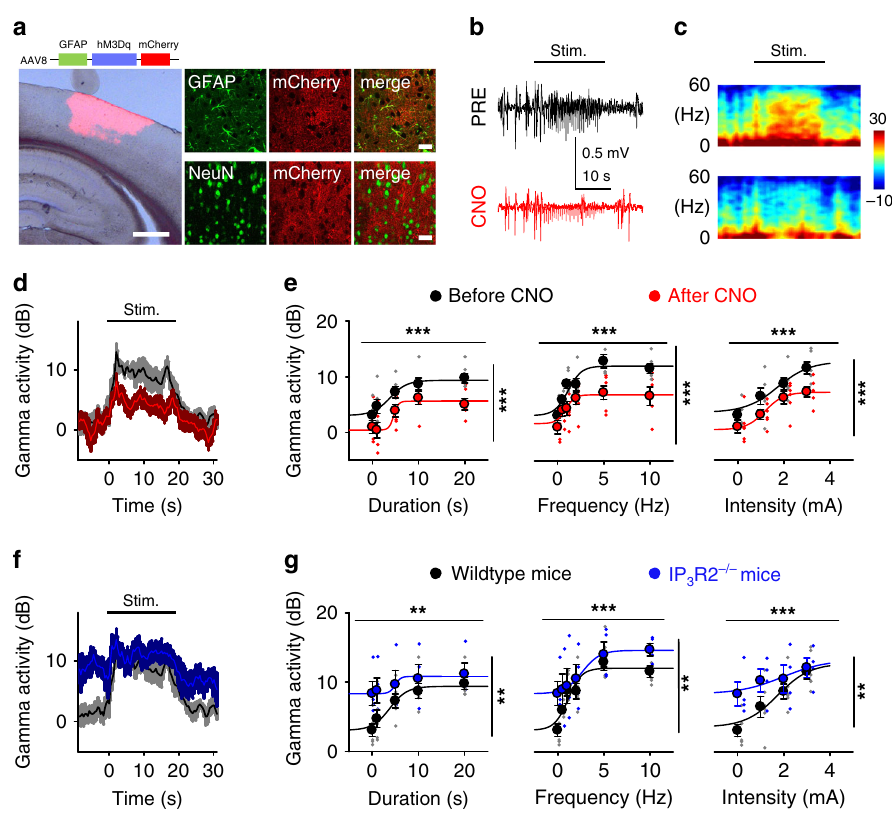
Fig. 5 Astrocytes modulate neuronal network response to sensory stimulation. a Viral expression of DREADDs in S1 astrocytes. Scale bars = 500 µ m, 10 µ m. b ECoG recordings during hind paw stimulation before (black top trace, PRE) and after (red bottom trace, CNO) i.p. injection of CNO. Images and traces are representative of independent experiments from 6 mice. c Spectrograms of b . d Gamma activity vs. time before (black) and after CNO (red). Lines and shadows represent mean and SEM, respectively, as in other panels. e Gamma activity vs. the duration, frequency and intensity of the sensory stimulation before (black) and after CNO (red) injection (duration: 2-way ANOVA for stimulus: p = 1.9e − 6 , for CNO: p = 1.3e − 5 ; frequency: 2-way ANOVA for stimulus: p = 1.9e − 8 , for CNO: p = 1.1e − 6 ; intensity: 2-way ANOVA for stimulus: p = 2.9e − 7 , for CNO: p = 3.4e − 4 ; n = 6 animals). Data were fi t to the sigmoid function in Eq. (2) (see Methods section; see Supplementary Table 2 for fi tting parameters). f – g , as d – e , but in wildtype (black) and IP 3 R2 − / − (blue) mice (duration: 2-way ANOVA for stimulus: p = 0.001, for genotype: p = 0.001; frequency: 2-way ANOVA for stimulus: p = 1.3e − 7 , for genotype: p = 0.002; intensity: 2-way ANOVA for stimulus: p = 0.0004, for genotype: p = 0.007; n = 6 animals). Note that data of before CNO and wildtype are the same. Mean ± SEM. ‘ *** ’ : p < 0.001 and ‘ ** ’ : p < 0.01 for 2-way ANOVA. Source data are provided as a Source Data fi